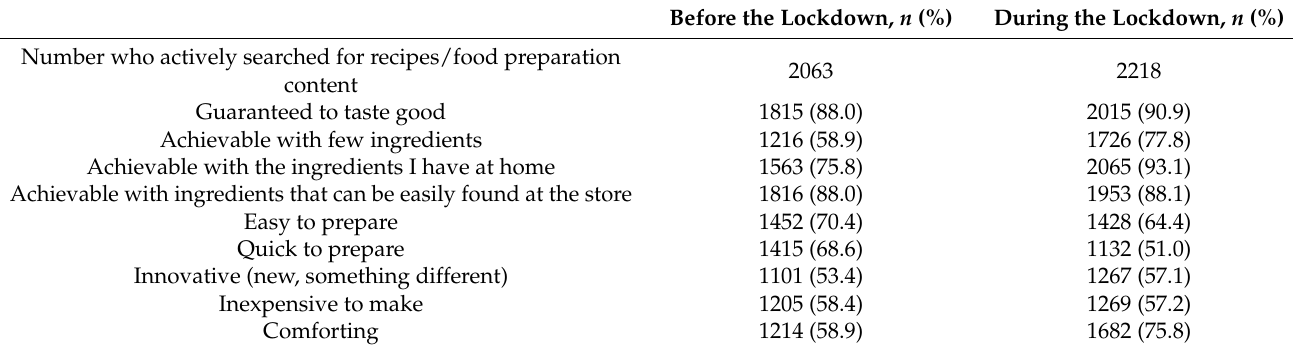
Table 2. Number (%) of participants according to the reasons for recipe selection before and during the